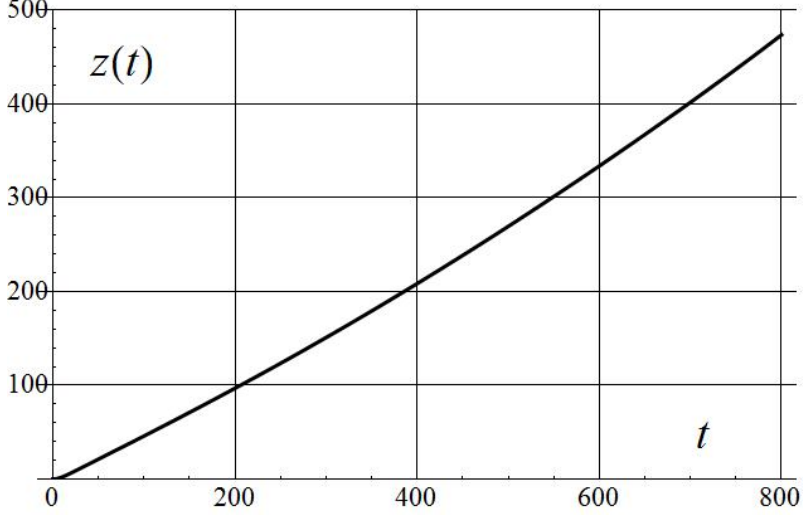
Figure 27. Submersion versus time: Northern seas, sphere, l ∗ = l s = 1/3, η = 0.005.